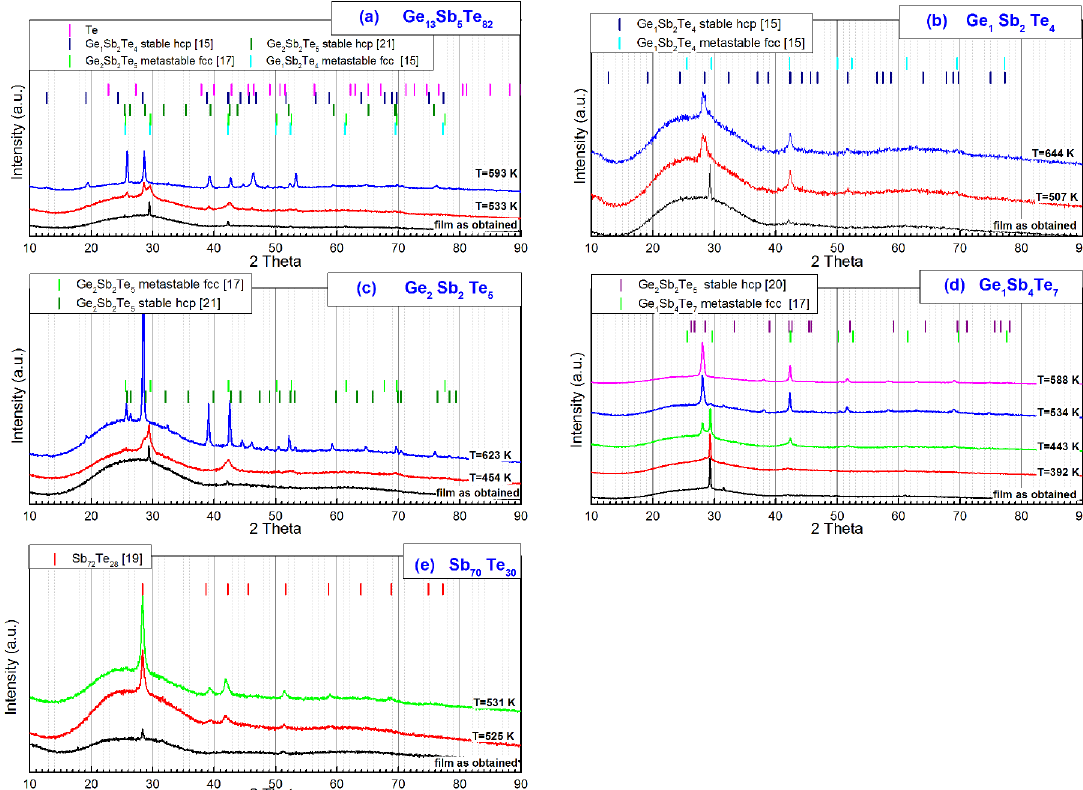
Sb Te , (b) Ge 13 5 82